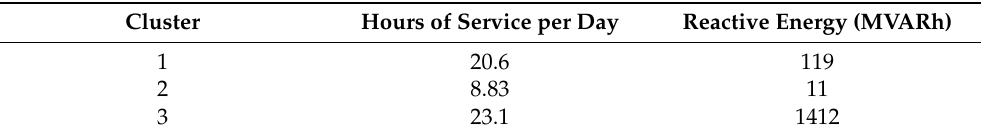
Table 6. Representative means of municipality clusters by K-medoids.